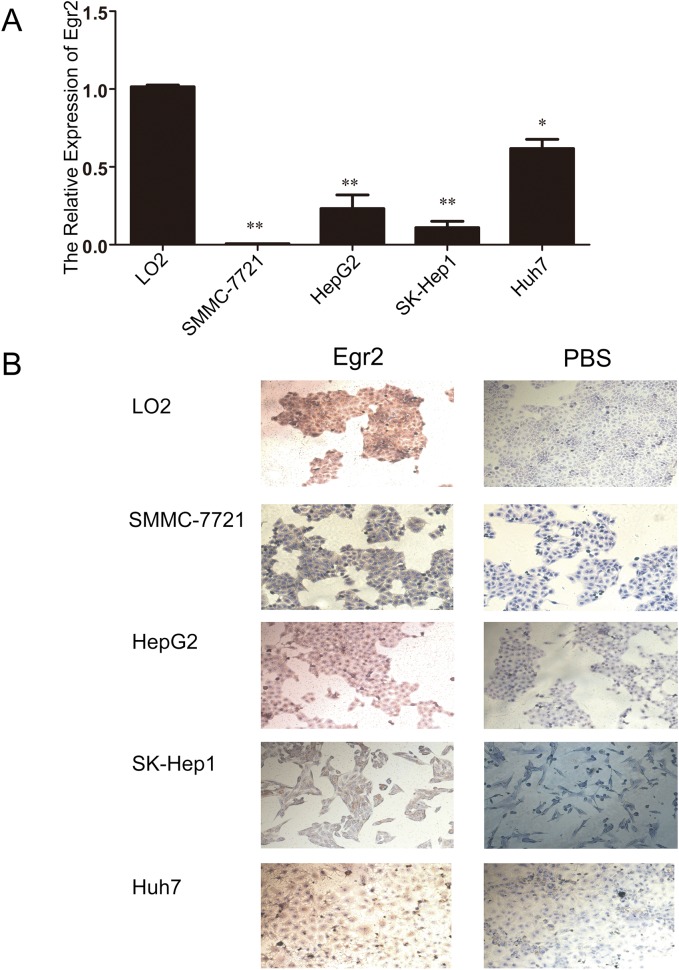
Egr2 was down-regulated in HCC cell lines.(A) Relative expression of Egr2 in L02 and HCC cells was analyzed by qRT-PCR. (B) Relative expression of Egr2 in L02 and HCC cells was detected by immunohistochemistry. *P<0.05, **P<0.01.